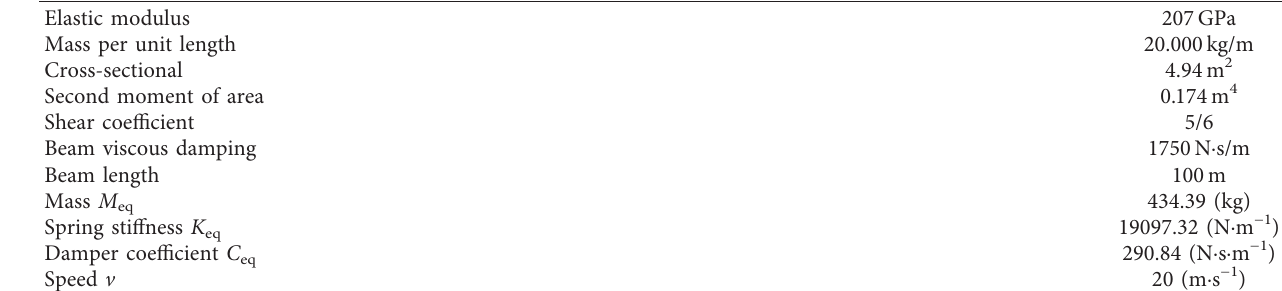
Figure 5: The established model of a vehicle on the bridge. Table 1: Parameters of the vehicle model on the